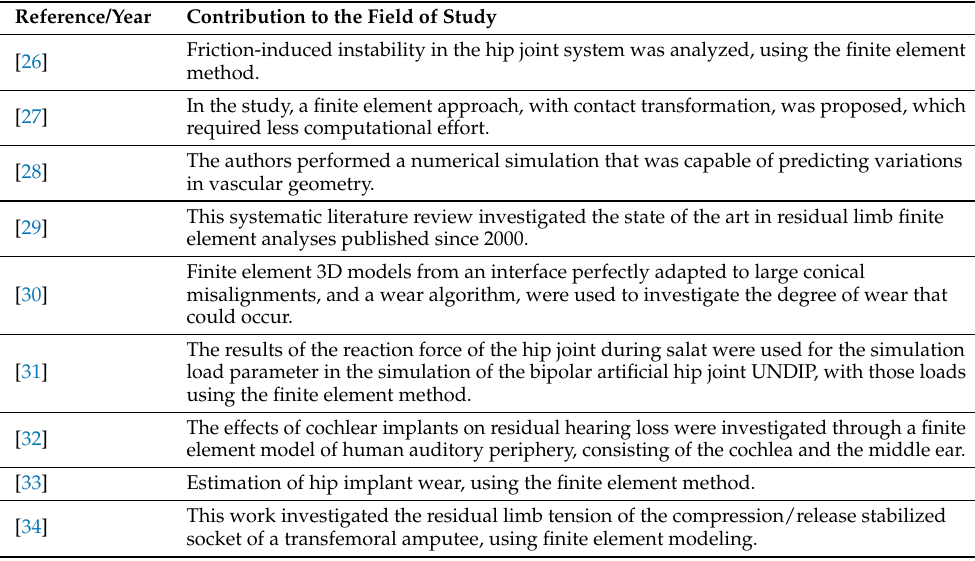
Table 1. Use of the FEM in investigations of the